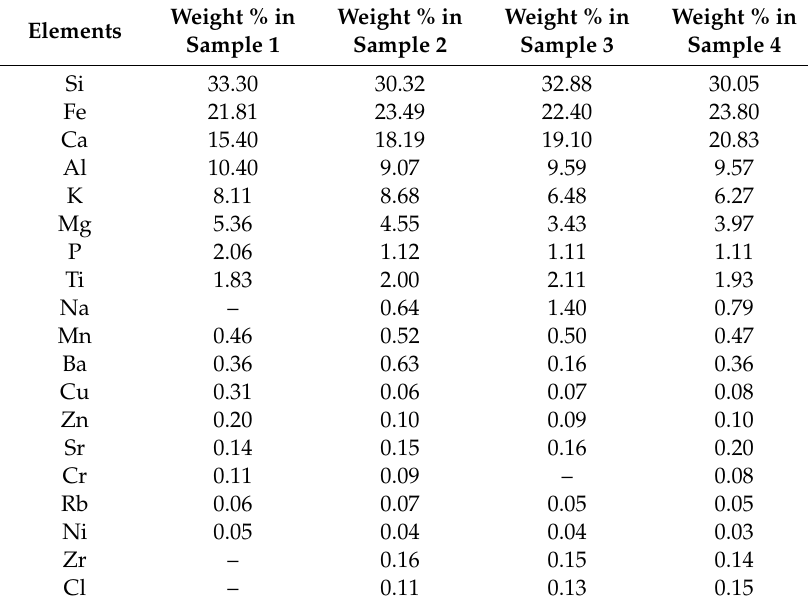
Table 2. Elemental composition of Segamat basalt from the XRF